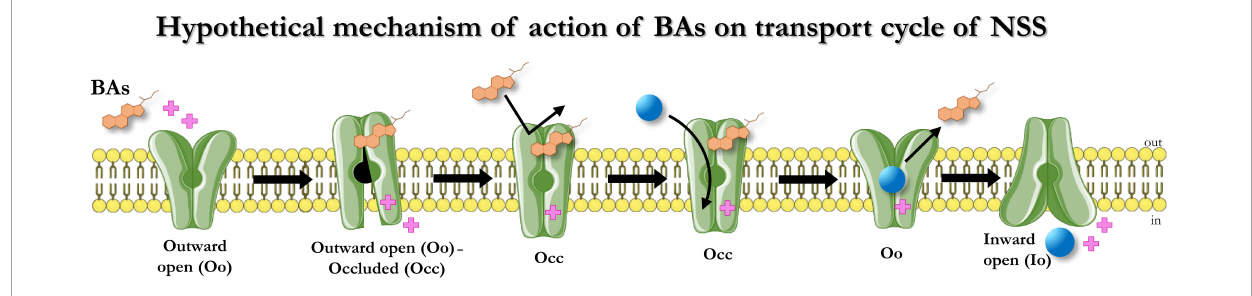
FIGURE6 Hypothetical mechanism of action of BAs on the transport cycle of NSS. In presence of BAs, the BA molecule binds the transporters (Oo), opens a transient conductance (Oo-Occ), and then freezes the protein in an occluded conformation (Occ) that makes it resistant to other BAs-mediated alteration of membrane potential. The occluded state can be recovered only in the presence of the physiological substrates that allow the transporter to switch from Oo to Io. The binding of the physiological transport induces the unbinding of OCA from the